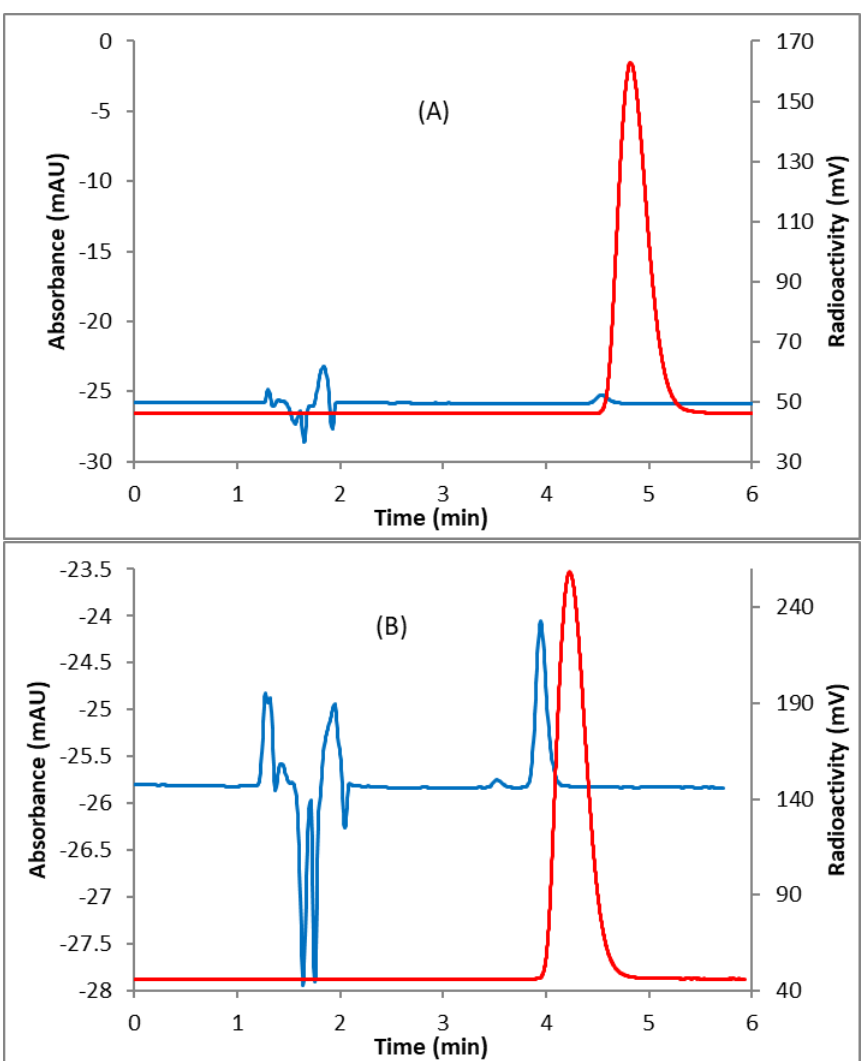
Figure 2. A representative HPLC profile for ( A ) compound [ 18 F] 1b ; ( B ) co-injected with the non- radioactive standard. Solid line, in-line radiodetector; blue line, UV detector at 254 nm.